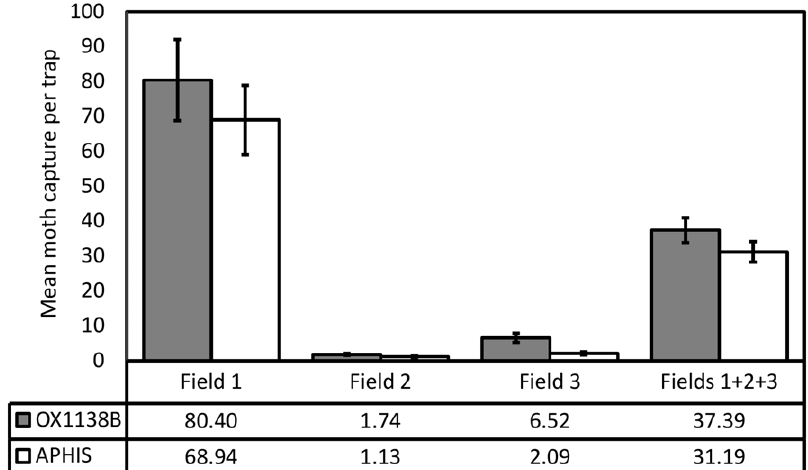
Figure 6. In-field recapture data during release period. Mean number of OX1138B and APHIS moths caught per trap is shown for each field separately, and for all three fields combined. Lower recapture rates in Fields 2 and 3 than in Field 1 were likely a result of pesticide treatment in the former. Filled bars=OX1138B, white bars=APHIS moths; error bars indicate Standard Error of Mean. The recapture rates of OX1138B and APHIS moths were significantly different (Poisson regression model, 95% CI: 7.8–33.3%; p , 0.01).